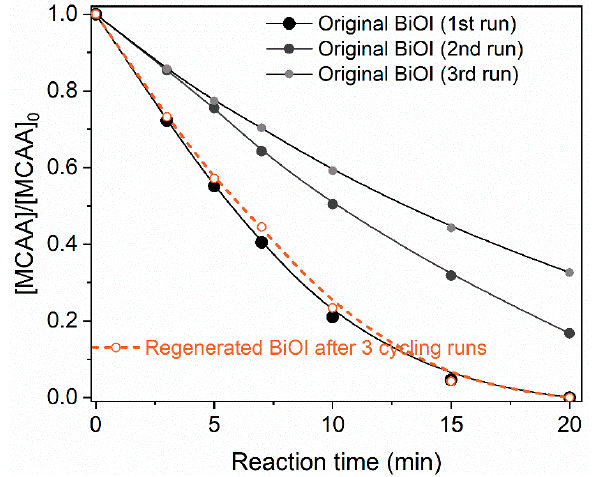
Figure 11. Enhancement effects of BiOI on MCAA degradation by UV/S(IV) in the cycling runs and regeneration test of used BiOI. Conditions: [BiOI] 0 = 1.0 g ⋅ L − 1 (84.9 μ M as I); [S(IV)] 0 = 1.0 mM; regeneration test of used BiOI. Conditions: [BiOI] 0 = 1.0 g · L − 1 (84.9 µ M as I); [S(IV)] 0 = 1.0 mM; [MCAA] 0 = 10 μ M; [DO] 0 = 0.22 mM (7.1mg ⋅ L − 1 ); pH = 7.0, 25 ± 1 °C. [MCAA] 0 = 10 µ M; [DO] 0 = 0.22 mM (7.1mg · L − 1 ); pH = 7.0, 25 ± 1 ◦